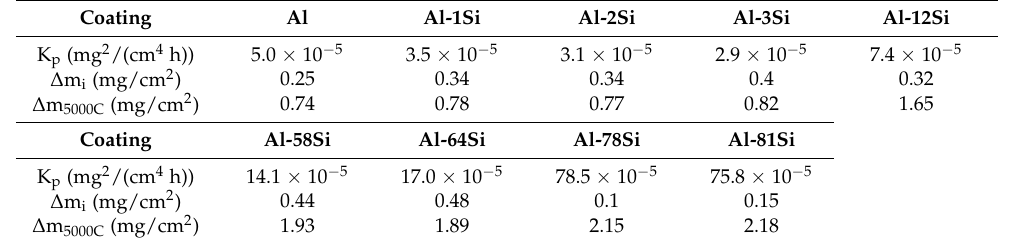
Table 4. Based on the cyclic oxidation tests, the estimated parabolic rate constants (K p ) of the different Al(-Si) coatings in mg 2 /(cm 4 h), as well as the mass change by the initial oxide formation ( ∆ m i ) in mg/cm 2 calculated with the data obtained during the first 1500 cycles and the total mass gain ( ∆ m 5000C (mg/cm 2 )), are determined after cyclic oxidation at 900 ◦ C up to 5000 cycles (1 h each cycle) on TNB-V2. K p and ∆ m i were calculated by the method suggested by Pieraggi [35]. Coating Al